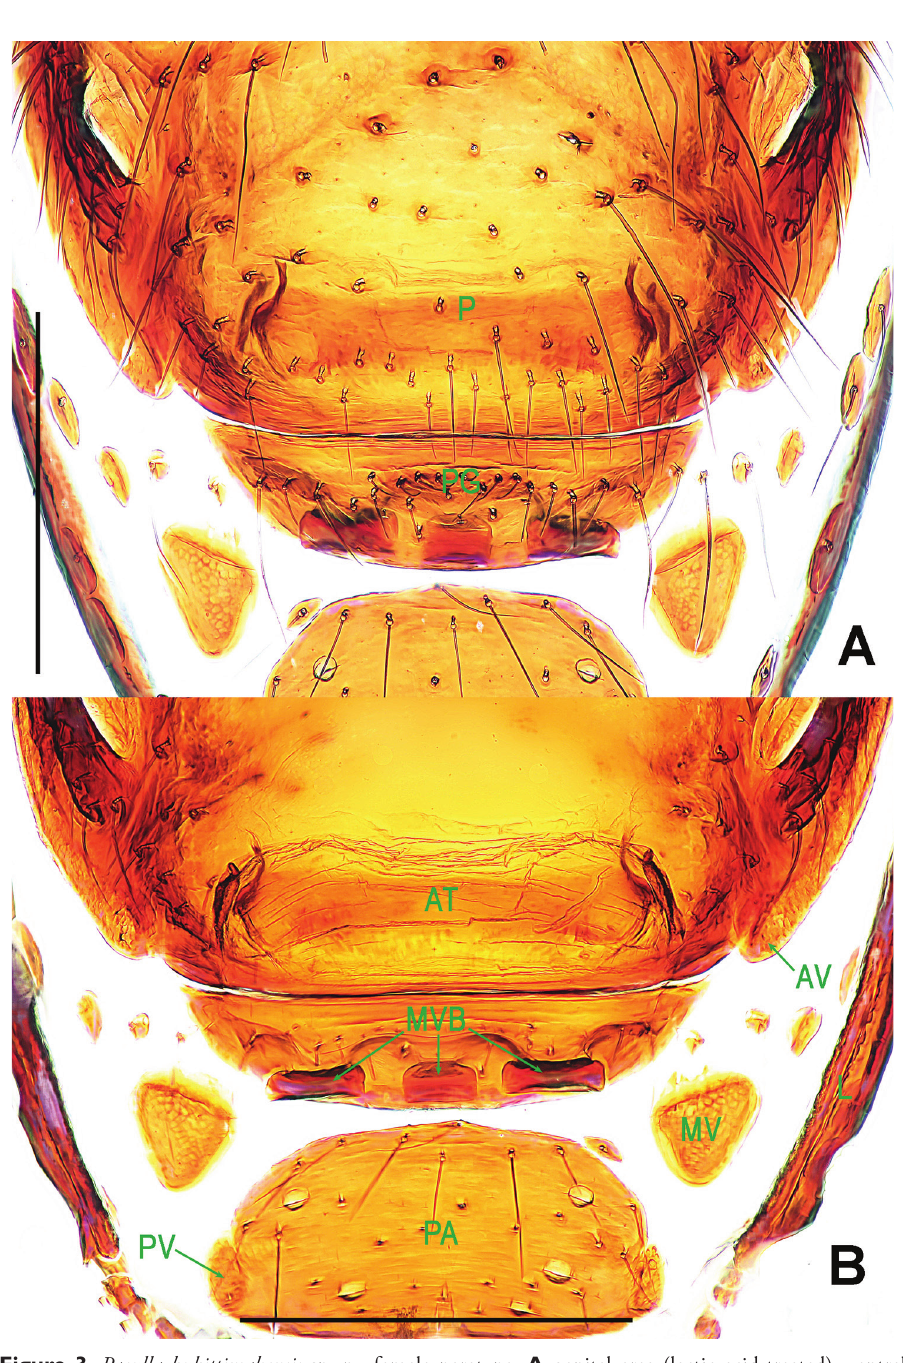
Figure 3. Paculla bukittimahensis sp. n., female paratype. A genital area (lactic acid-treated), ventral B ditto , dorsal. Abbreviations: AT = atrium; AV = anterior ventrolateral plate; MV = median ventrolateral plate; MVB = bridge fragments of MV; P = pulmonary plate; PA = preanal plate; PG = postgenital plate; PV = posterior ventrolateral plate. Scale bars: 0.50